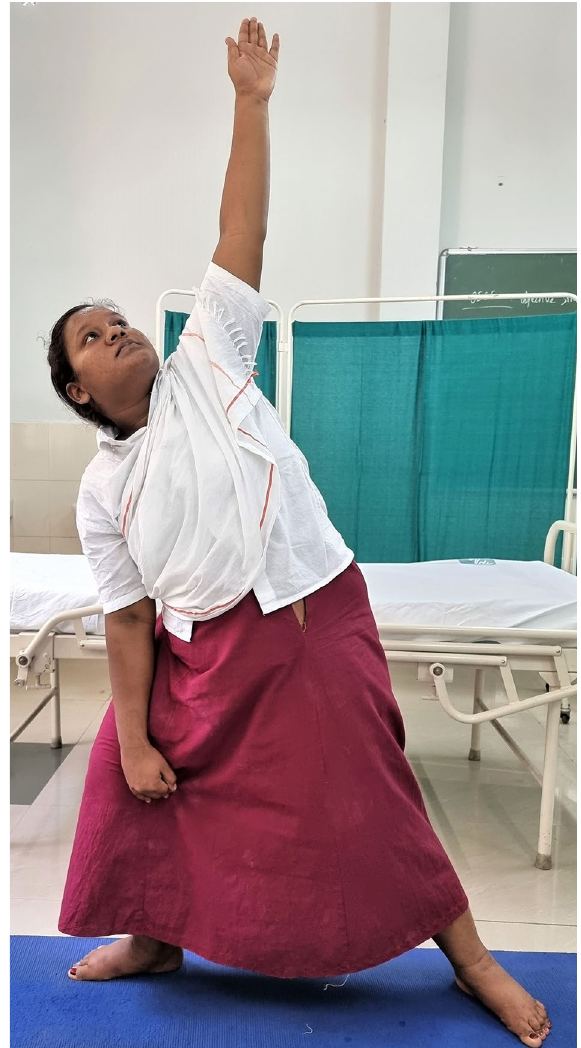
Figure 5. Trikonasana (Modified).